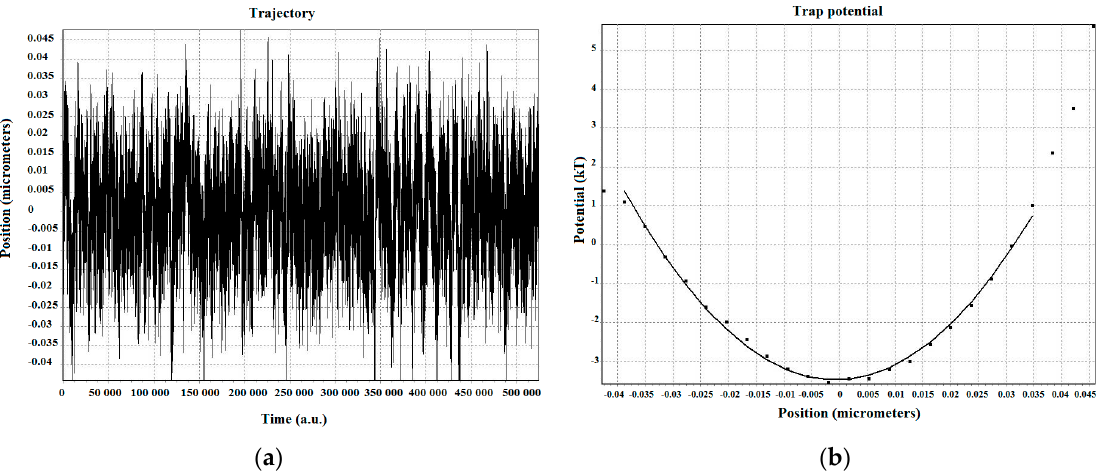
Figure 6. ( a ) Trajectory of trapped pairs of same diameter-sized silica beads and ( b ) the potential well and fit of the trapped 2 µm diameter silica bead attached to the silica bead of 2 µm diameter at a depth of ≈ 5.6 µm from the glass surface with trapping laser power ≈ 61.94 mW.